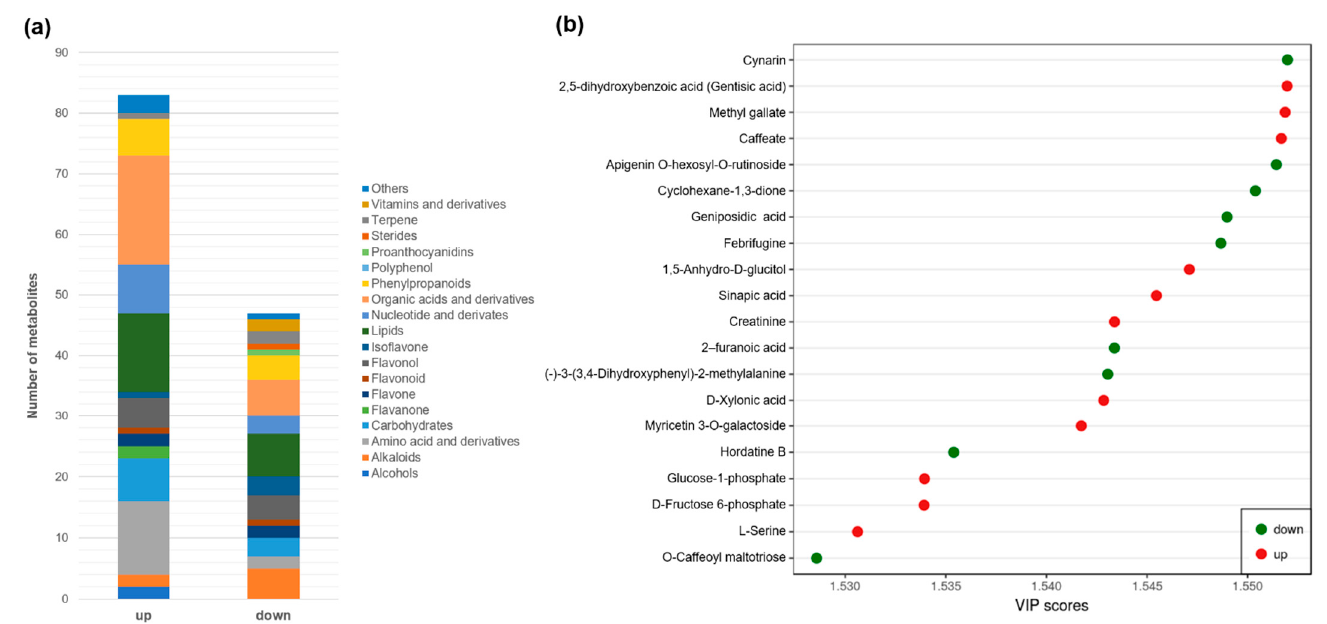
Figure 5. Classes of differentially accumulated metabolites of white clover roots grown under a low versus high phosphorus treatment ( a ) and the top 20 differentially expressed metabolites as shown by variable importance in projection (VIP) scores ( b ).